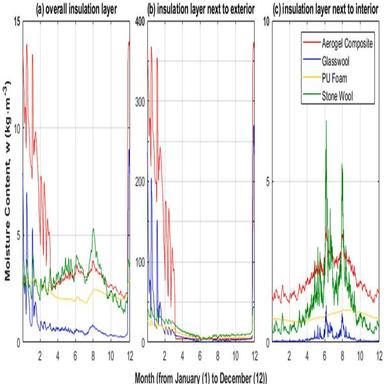
Moisture Content w for the aerogel composite and reference materials in a masonry wall with 6 cm cavity thickness, showing (a) overall insulation layer, (b) at insulation layer next to the exterior and (c) next to the interior.